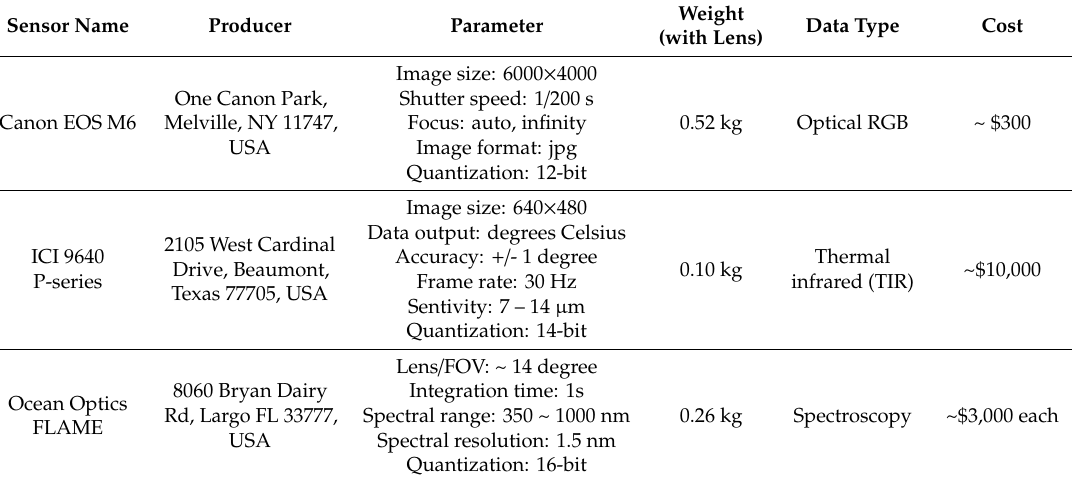
Table 1. Technical details of the three types of sensor applied on the Osprey. The total cost of the platform was about $18,000, including the aircraft, sensors, and other accessories (estimated based on the price in